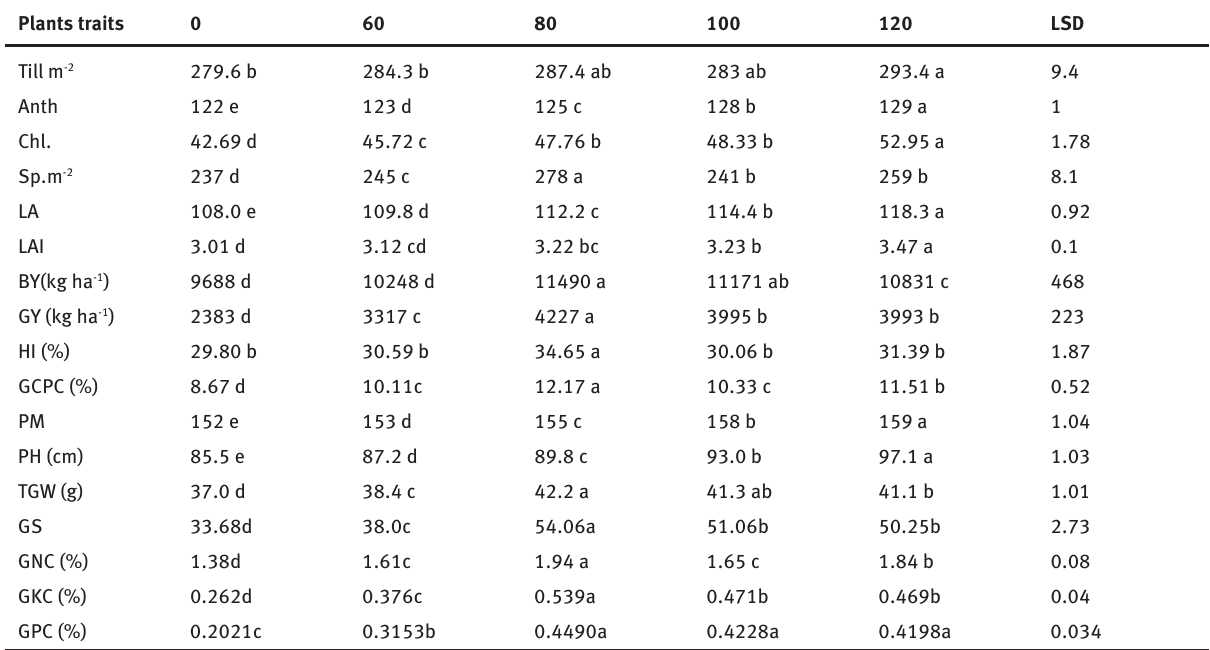
Table 2: Phonological, physiological, yield, yield components and grain nutrients contents of wheat as influenced by K levels Plants